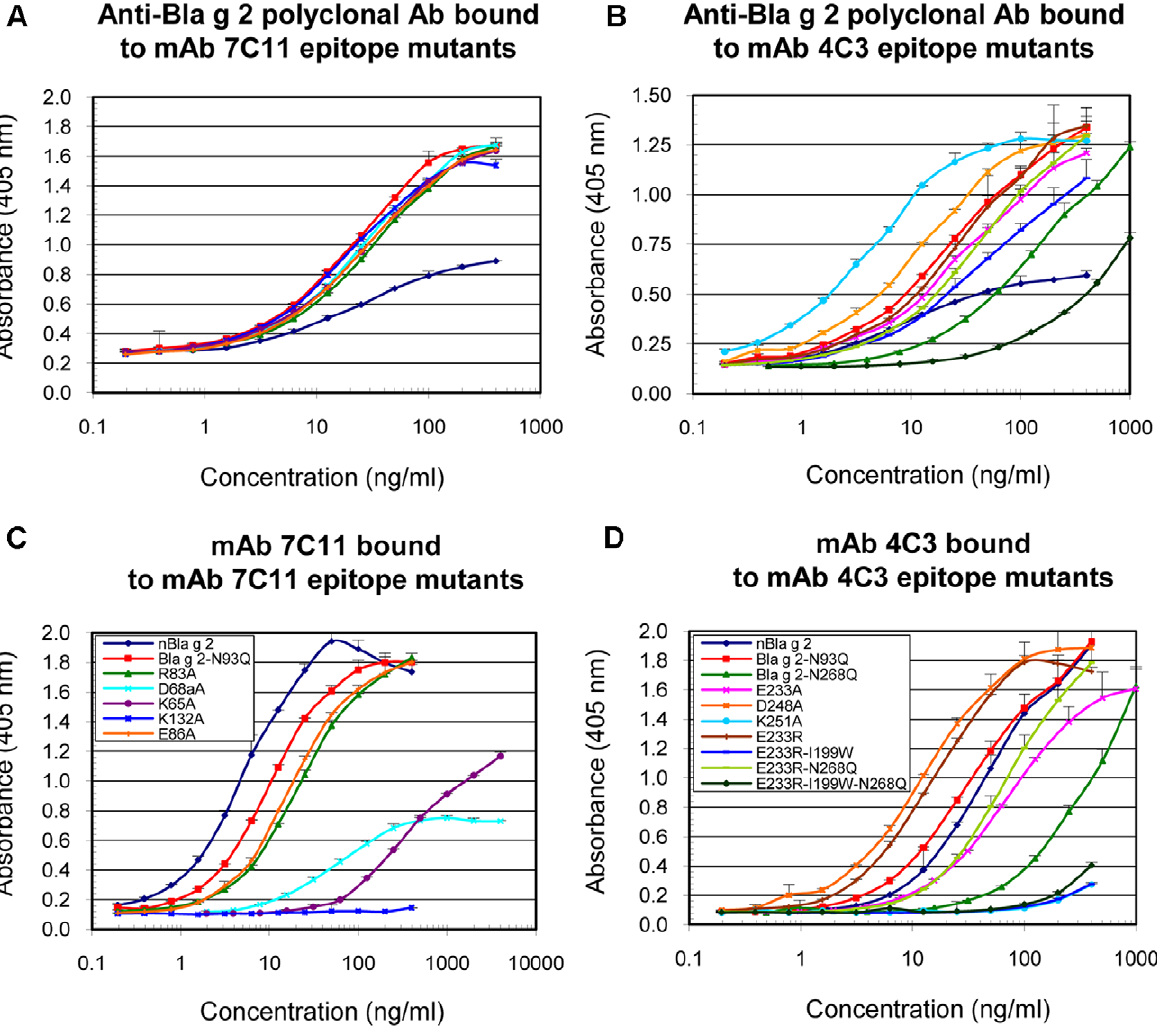
Figure 6. Dose-response curves of Bla g 2 and epitope mutants by ELISA. A) Binding of the anti-Bla g 2 polyclonal antibody to mAb 7C11 epitope mutants. B) Binding of the anti-Bla g 2 polyclonal antibody to mAb 4C3 epitope mutants. C) Binding of mAb 7C11 to mAb 7C11 epitope mutants, D) Binding of mAb 4C3 to mAb 4C3 epitope mutants. Data are mean 6 standard deviation of duplicates from one representative experiment out of two performed for each panel. Legends in panels C and D also apply to panels A and B,